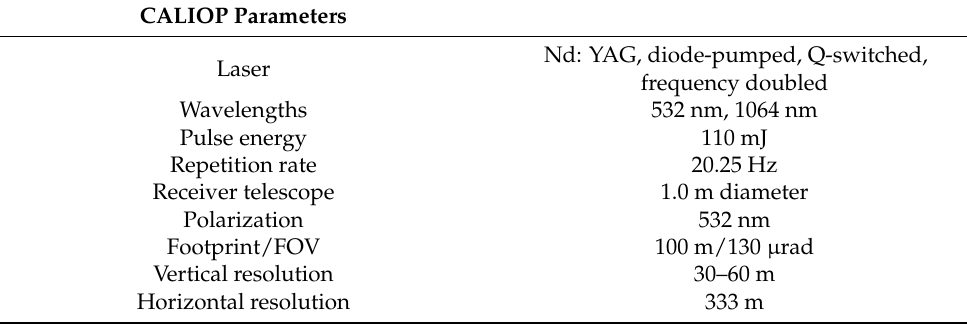
Table 2. Specifications of